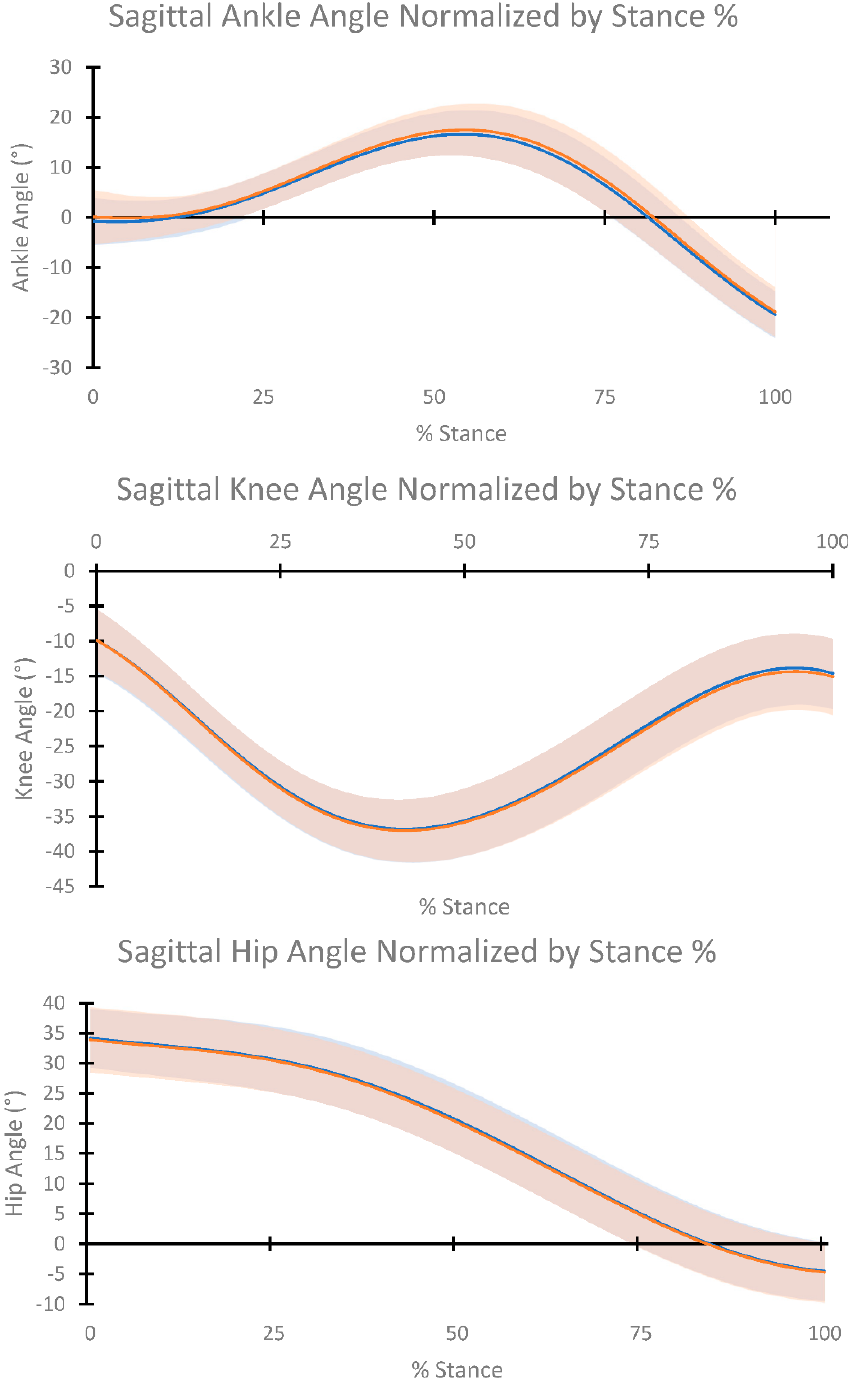
Figure 2. Average sagittal plane joint angles of the ankle, knee, and hip in the dominant leg normal- ized by % stance. The shaded areas represent standard deviations for each part of the stance phase. The female shoe (C1) is represented in blue, and the male shoe (C2) is represented in orange.